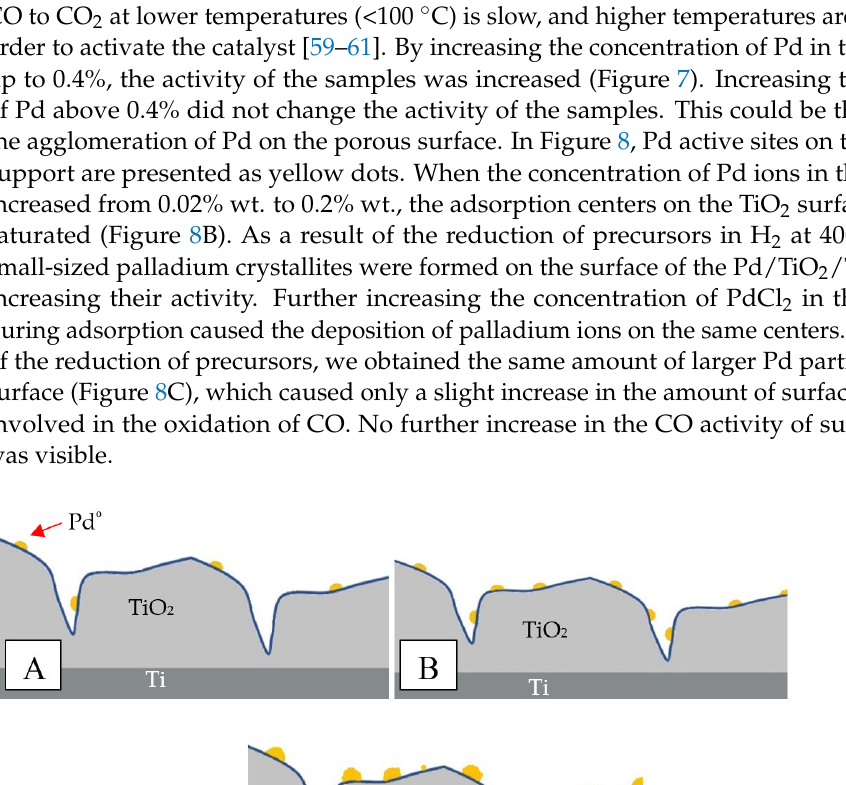
Figure 7. Catalytic activity of samples of Pd/TiO 2 /Ti catalysts with different amounts of palladium. The adsorption of CO on Pd is known to be quite strong. Therefore, the conversion